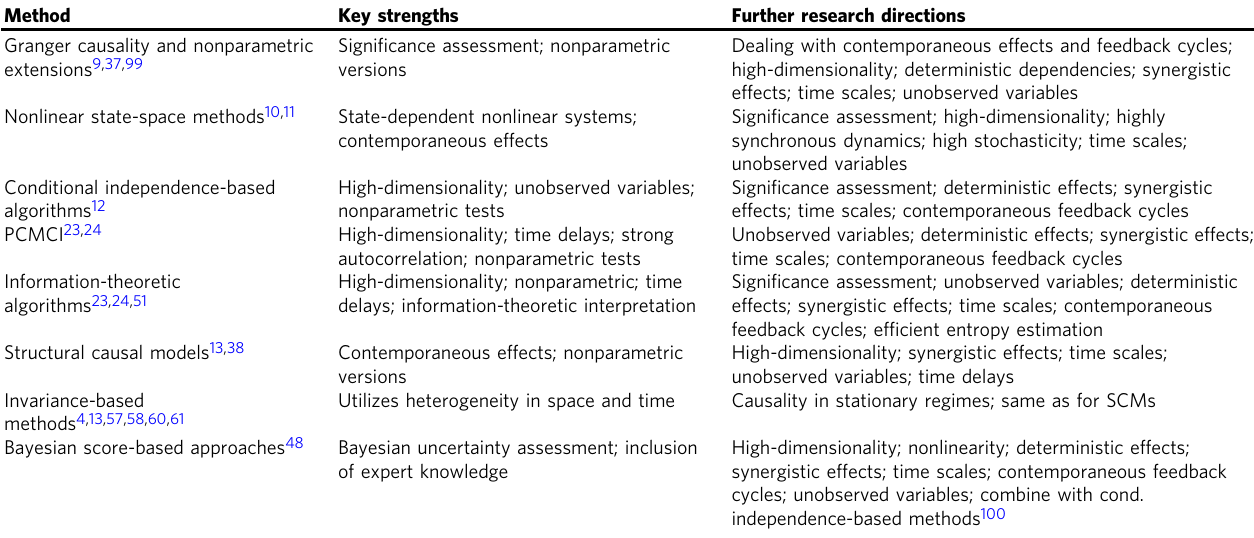
Table 1 List of methods, key strengths, and further research directions addressing current limitations Method Key